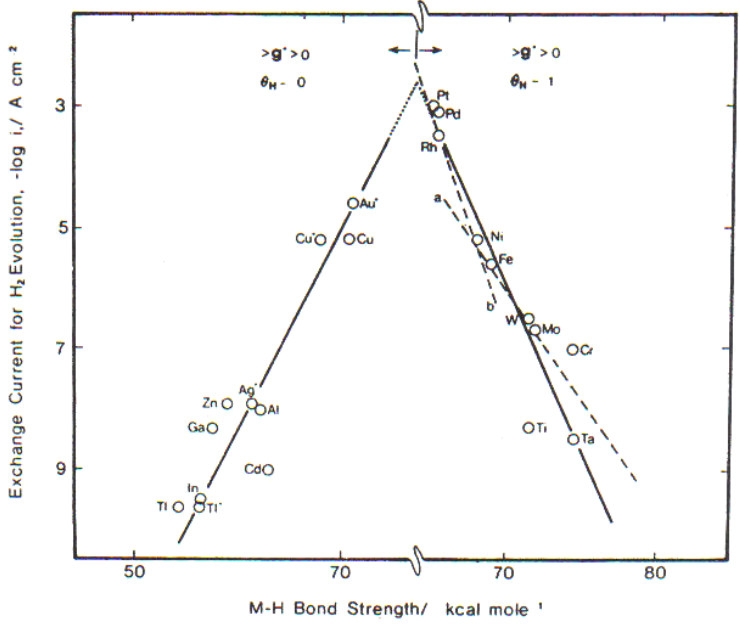
Figure 2. A plot of exchange current density for hydrogen evolution reaction vs. M–H bonding strength (Reprint from [5] and